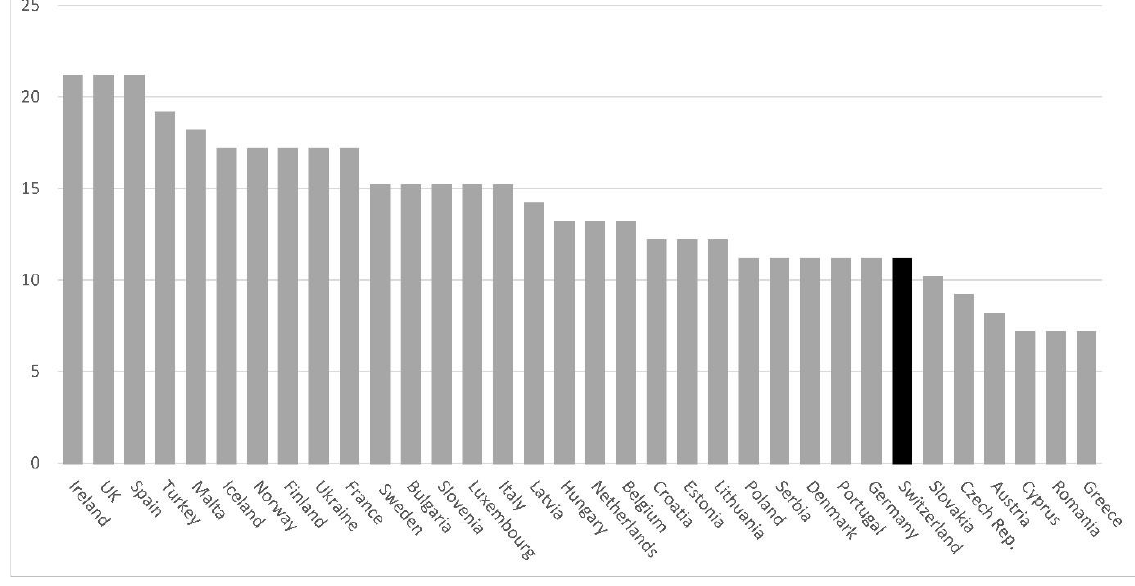
Figure 3: European countries ranked by TCS score for smoke-free policies. Source: Tobacco Control Scale in Europe 2013